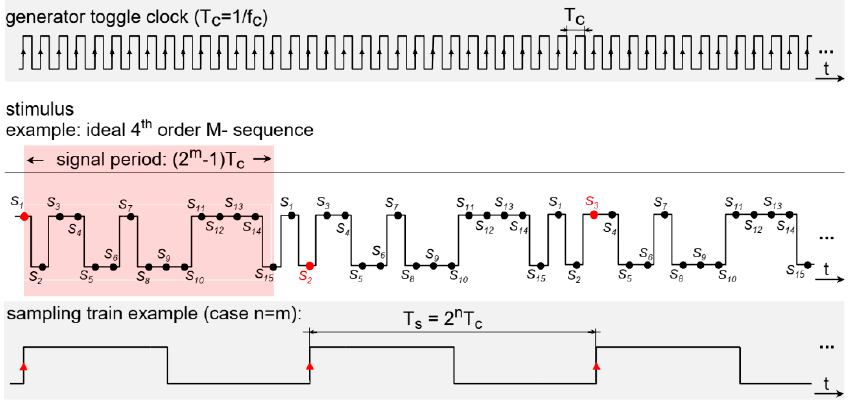
Figure 3. The timing diagram example of the equivalent time sampling for a 4th-order M-sequence.